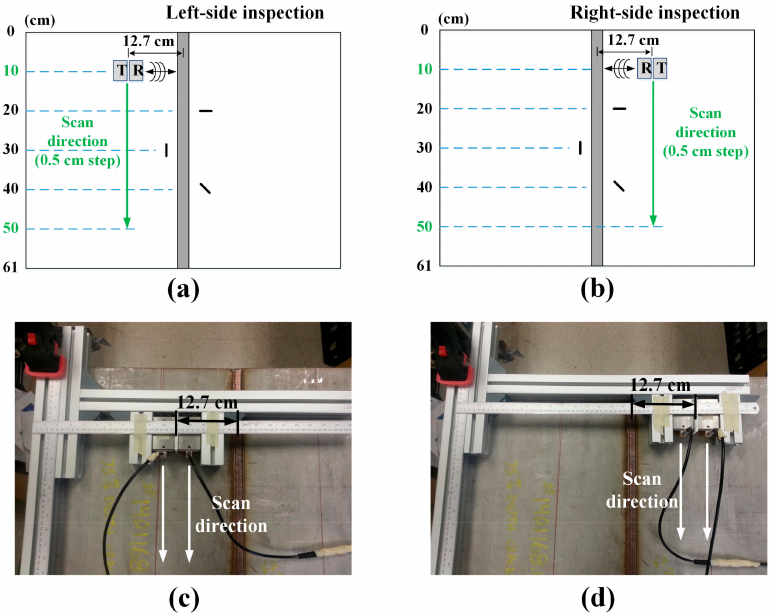
Figure 14. Notched plate inspection schemes and corresponding experimental setups: ( a , c ) left-side inspection; and ( b , d ) right-side